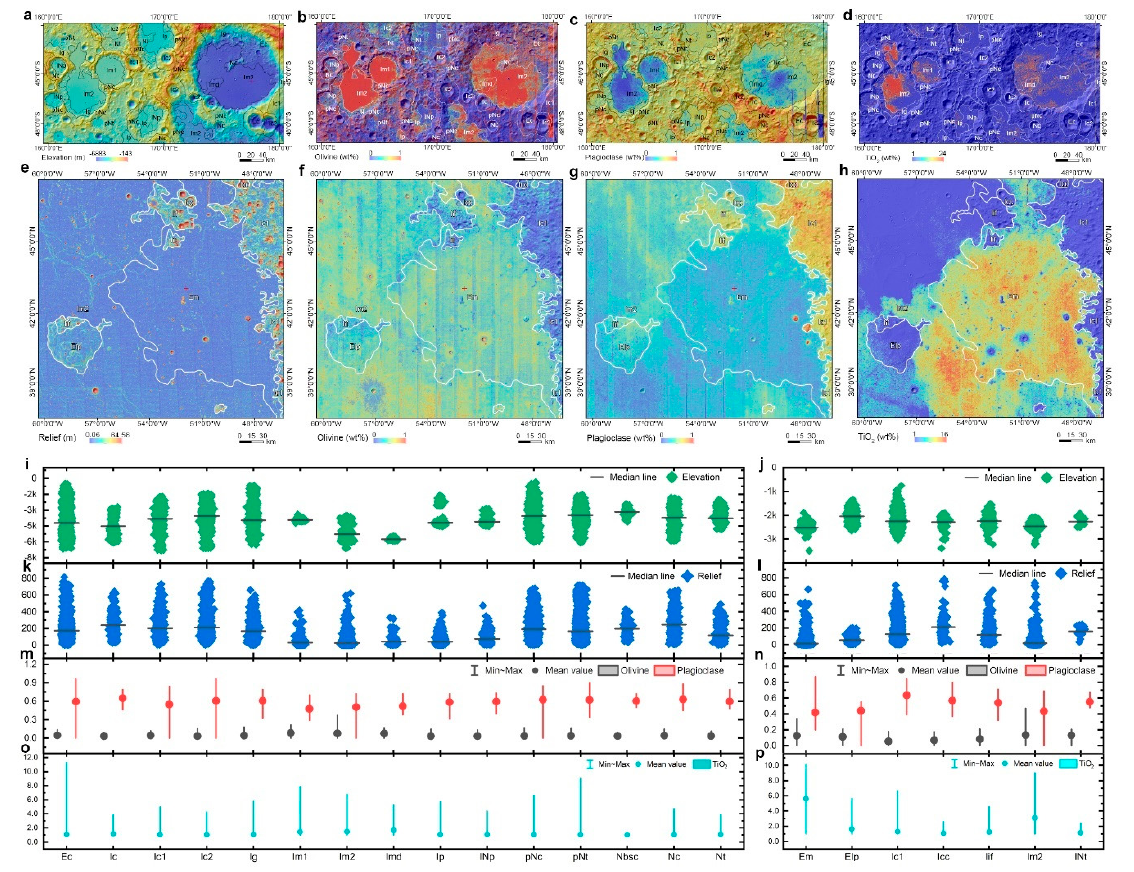
Figure 8. Feature distribution and statistics of featured geological unit classification. ( a ) Topographic elevation distribution of CE-4 landing area. ( b ) Olivine abundance of CE-4 landing area. ( c ) Plagioclase content of CE-4 landing area. ( d ) TiO2 content of CE-4 landing area. ( e ) Relief of CE-5 landing area. ( f ) Olivine content of CE-5 landing area. ( g ) Plagioclase content of CE-5 landing area. ( h ) TiO2 distribution of CE-5 landing area. ( i ) Statistic of elevation of classified geological units for CE-4 landing area. ( j ) Statistic of elevation of classified geological units for CE-5 landing area. ( k ) Statistic of relief of classified geological units for CE-4 landing area. ( l ) Statistic of relief of classified geological units for CE-5 landing area. ( m ) Statistic of olivine and plagioclase of classified geological units for CE-4 landing area. ( n ) Statistic of olivine and plagioclase of classified geological units for CE-5 landing area. ( o ) Statistic of TiO2 of classified geological units for CE-4 landing area. ( p ) Statistic of TiO2 of classified geological units for CE-5 landing area.